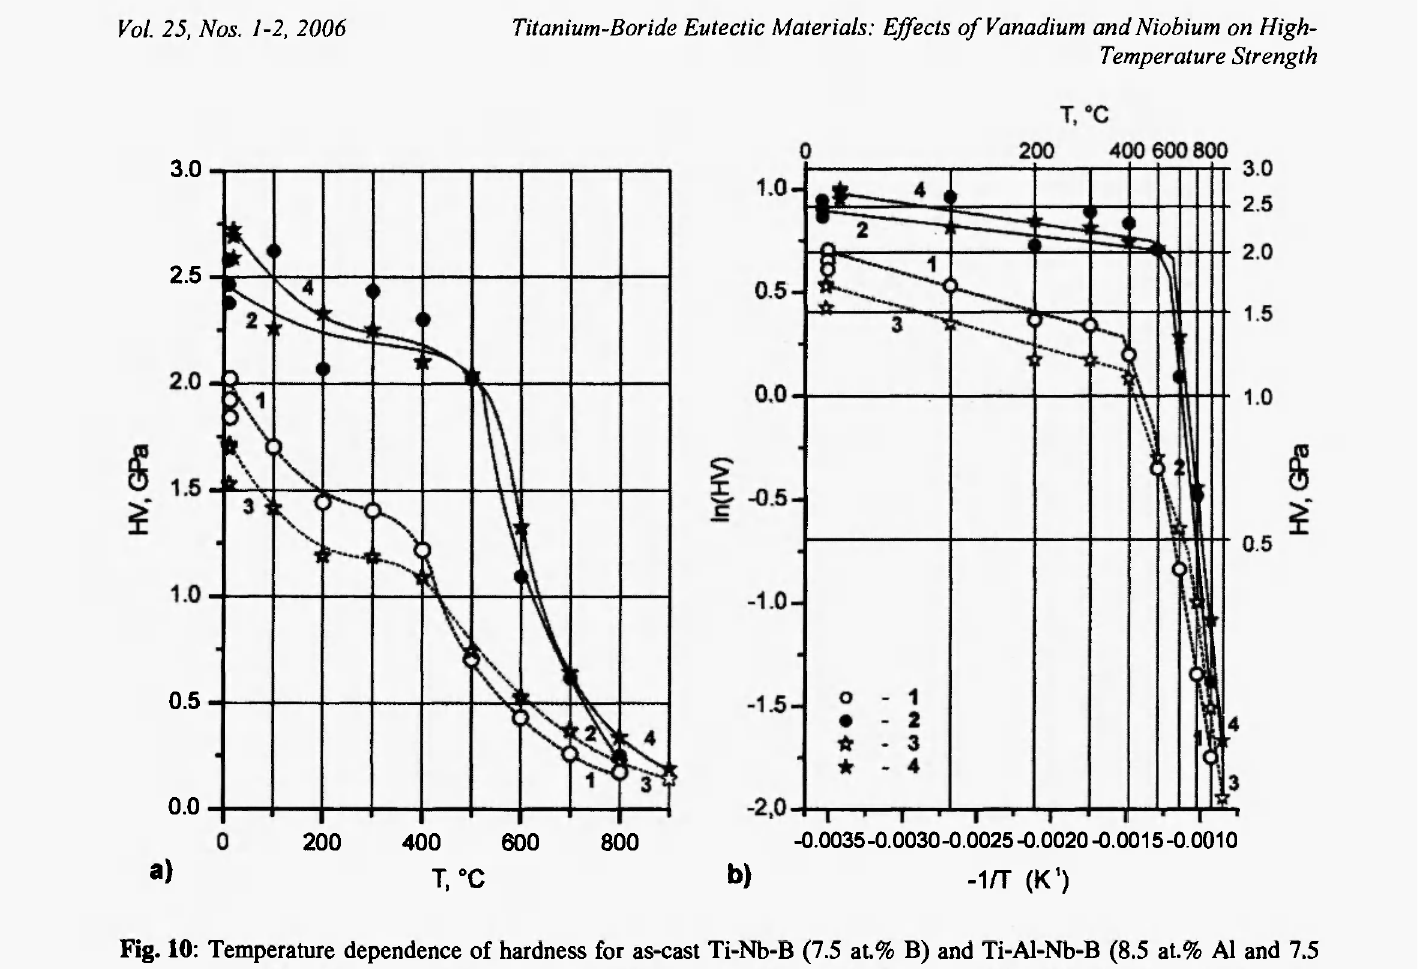
Fig. 10: Temperature dependence of hardness for as-cast Ti-Nb-B (7.5 at.% B) and Ti-Al-Nb-B (8.5 at.% Al and 7.5 at.% B) alloys containing ß-matrix, HV vs. Τ (a) and ln(HV) vs. -1/T (b). 1, Tifig.oNb^By.s;